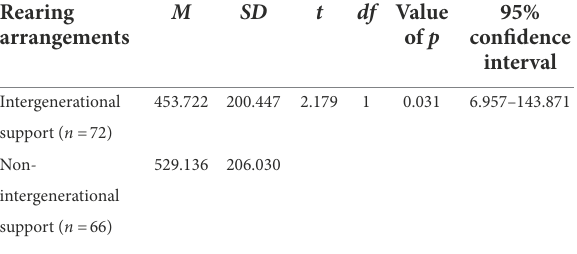
TABLE 2 The t -test results of the delay time of young children under different rearing arrangements (unit: s). Rearing